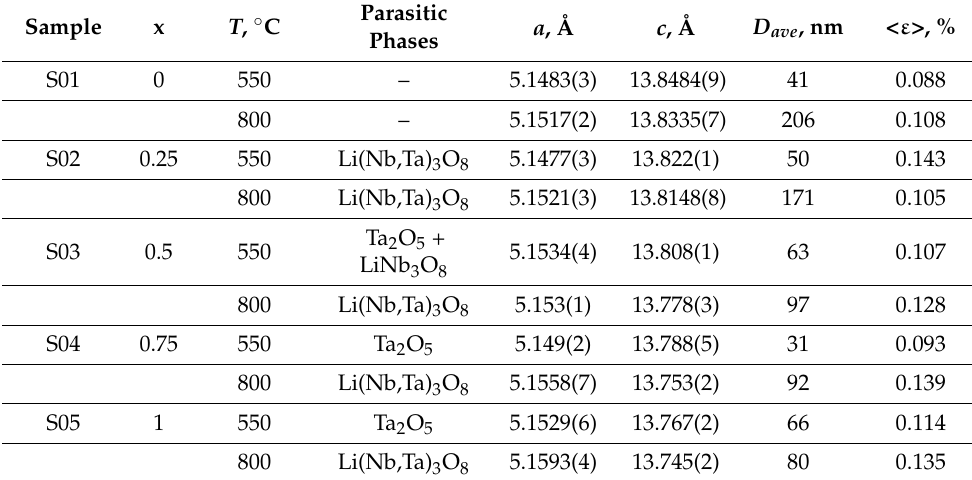
Observable broadening of the Bragg’s peaks on the nanocrystalline character for the powders was revealed. Additional heat treatment of the materials at 800 ◦ C led to the narrowing of the diffraction peaks and to the considerable change of the phase composition of the LiNb 1 − x Ta x O 3 samples with x from 0.5 to 1, in which the increase of monoclinic LiNb 3 O 8 or Li(Nb,Ta) 3 O 8 phases and disappearing of individual Ta 2 O 5 and Nb 2 O 5 oxides were detected (see, e.g., Figure 5). No significant changes of the phase composition in the samples with x = 0 and 0.25 were observed after such annealing of the samples.